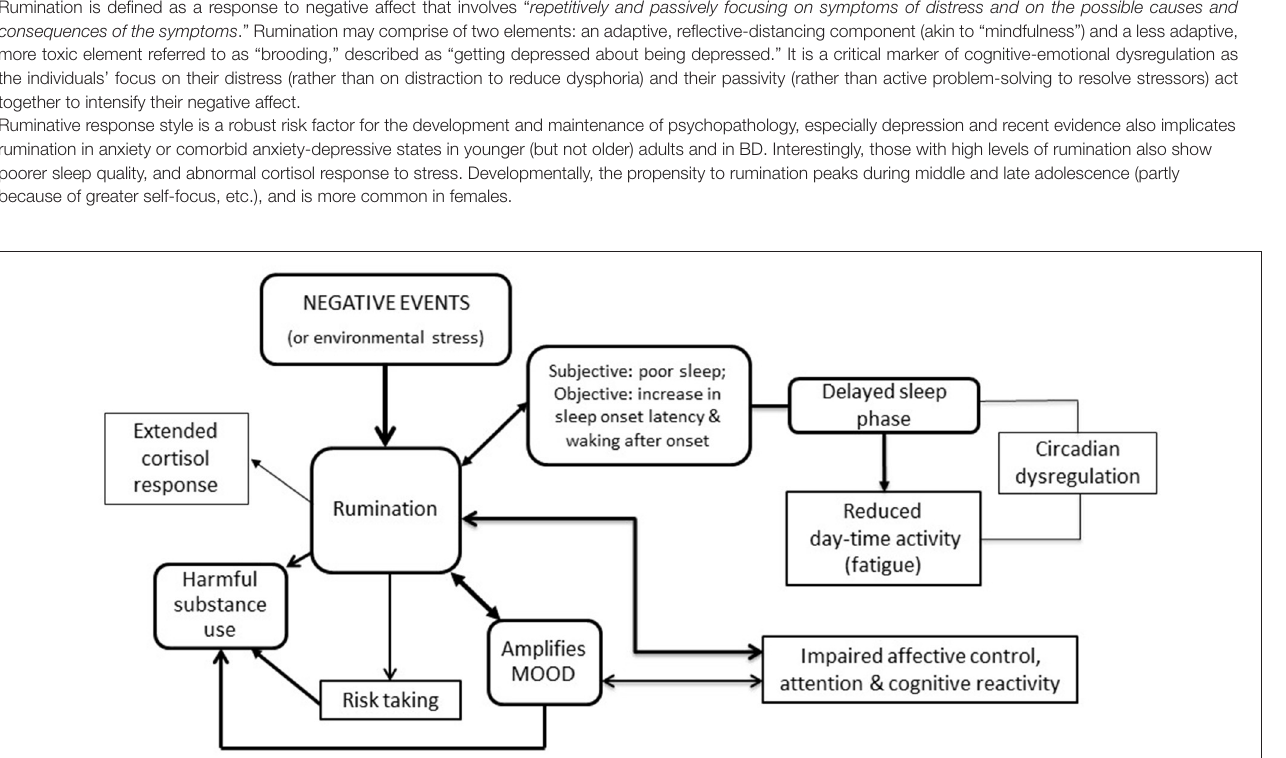
of England Research and Ethics committee (Refs: